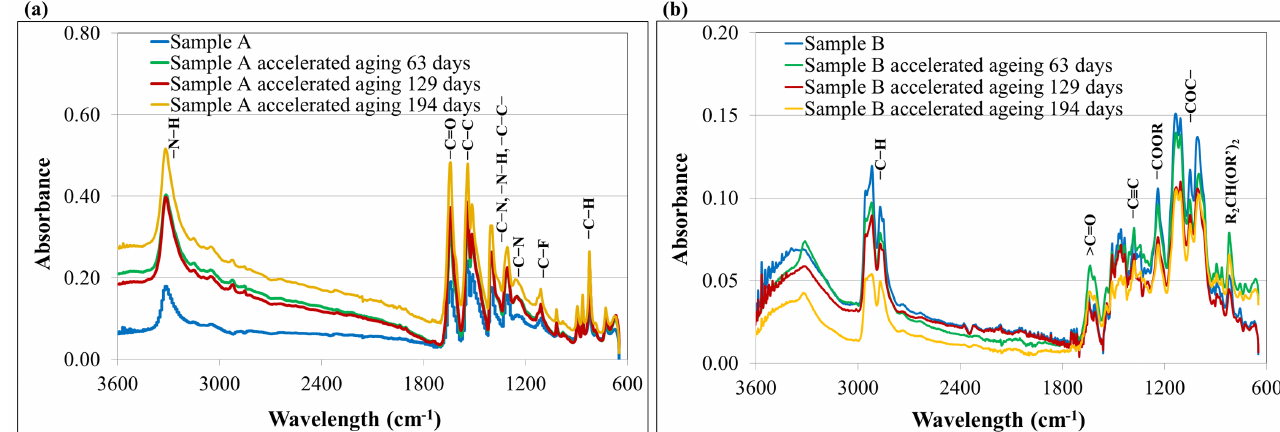
Figure 2. FT-IR spectra of sample A ( a ) and sample B ( b ) non-aged and subjected to accelerated aging processes.